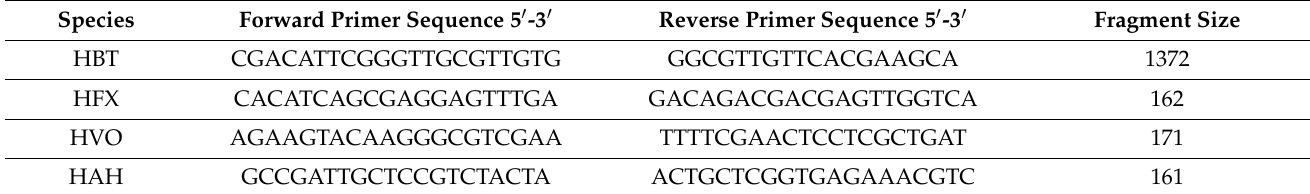
Table 4. Primers used to check for genomic